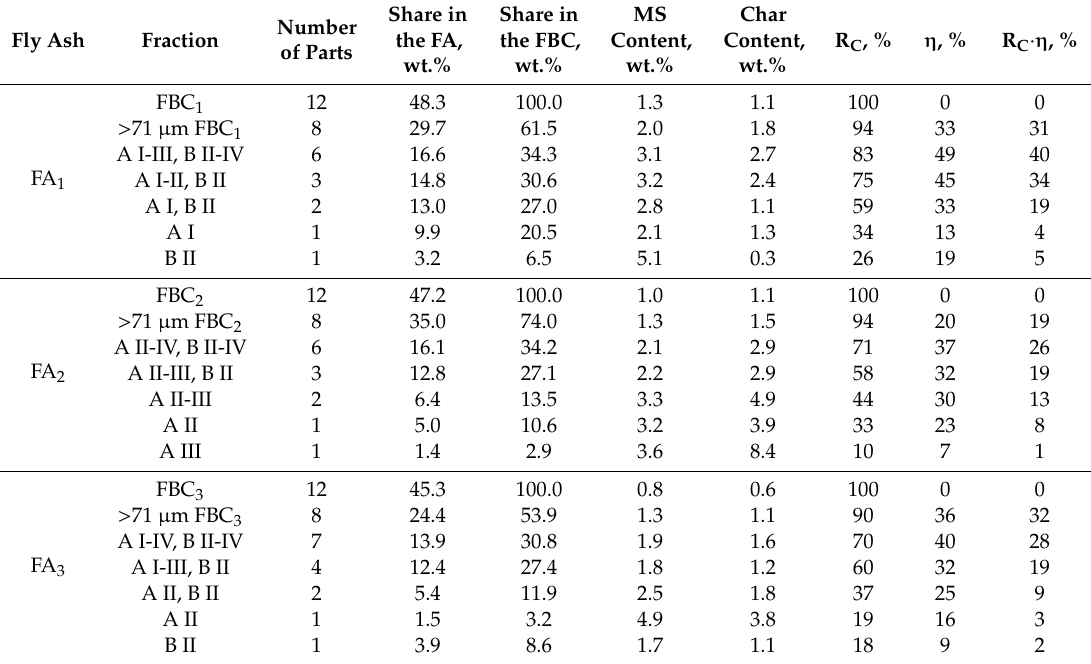
Table 6. Di ff erent variants of the MS recovery dry